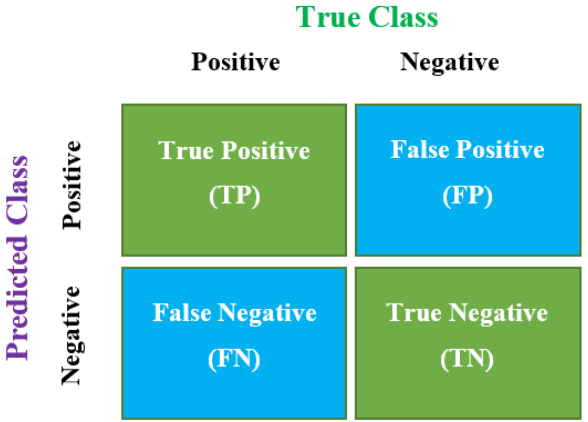
Figure 5. Confusion matrix.